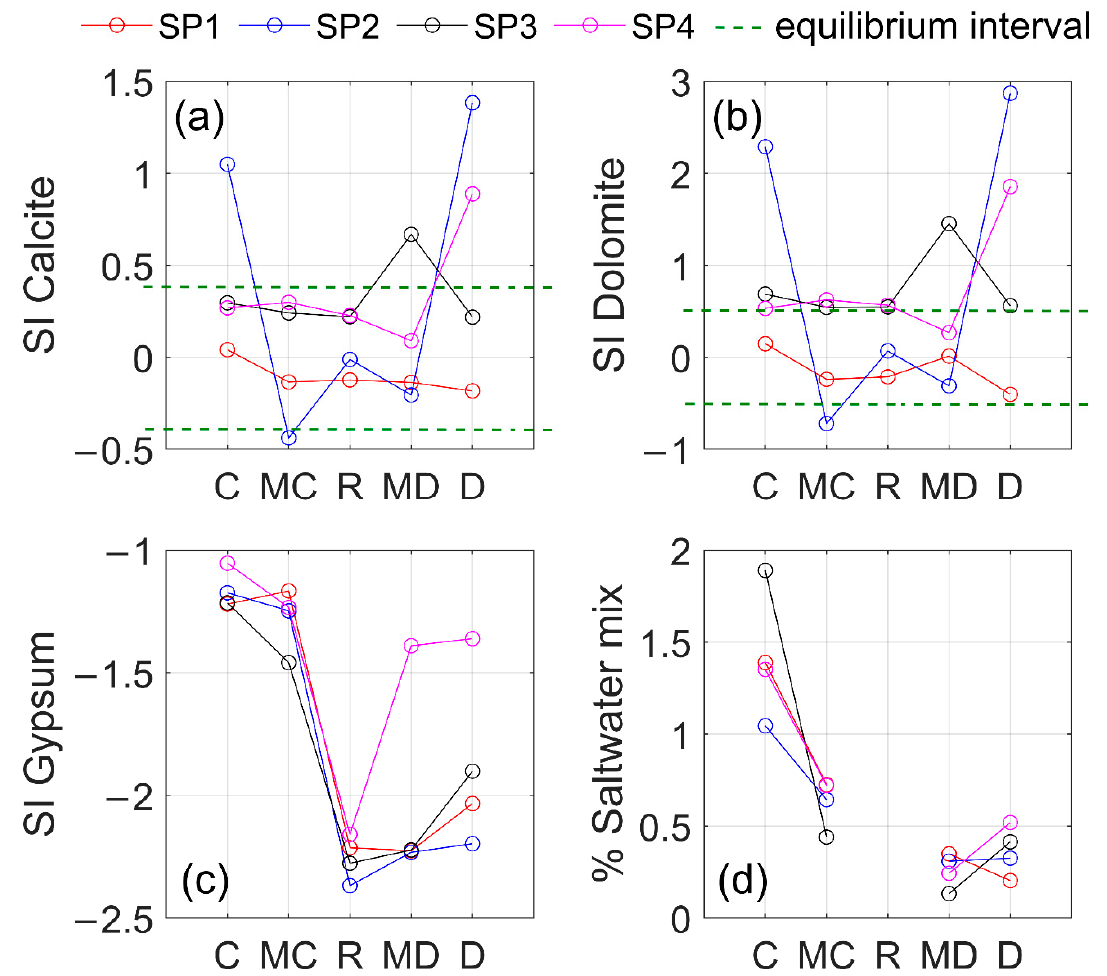
Figure 4. Saturation indexes for ( a ) Calcite, ( b ) Dolomite, and ( c ) Gypsum. ( d ) Percentage of seawater mixed with the groundwater. The dotted lines show the balance interval for calcite and dolomite. The mineral values under the lower limit are not shown. Labels: Recharge zone (R), middle Celestun (MC), the coast of Celestun (C), middle Dzilam Bravo (MD), the coast of Dzilam Bravo (D).